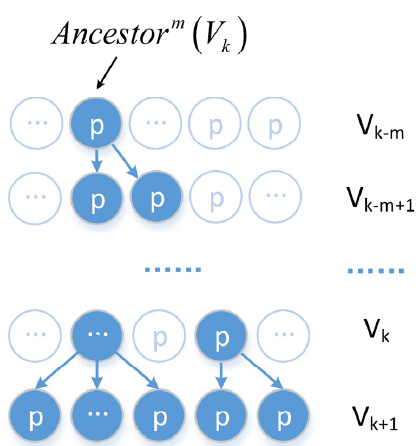
Figure 12. The m generation of ancestors of (cid:1848) (cid:3038) .